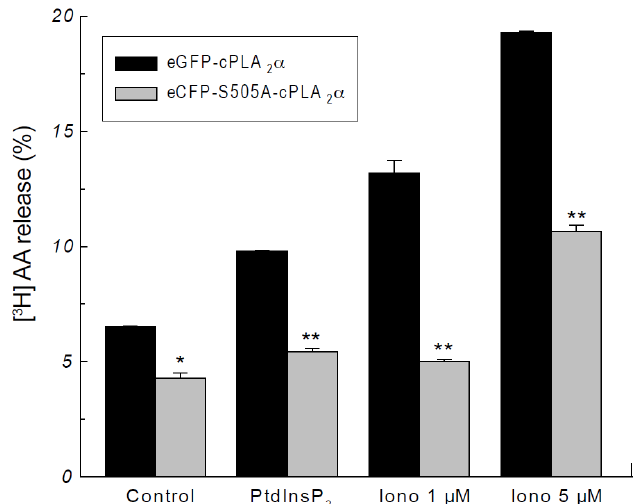
Figure 3. cPLA 2 α phosphorylation is necessary for AA release. HEK cells stably transfected with the construct eGFP-cPLA 2 α (black bars) or eCFP-S505A-cPLA 2 α (gray bars) were prelabeled with [ 3 H]AA and treated with vehicle (Control), PtdInsP 2 /histone, 1 µ M or 5 µ M ionomycin